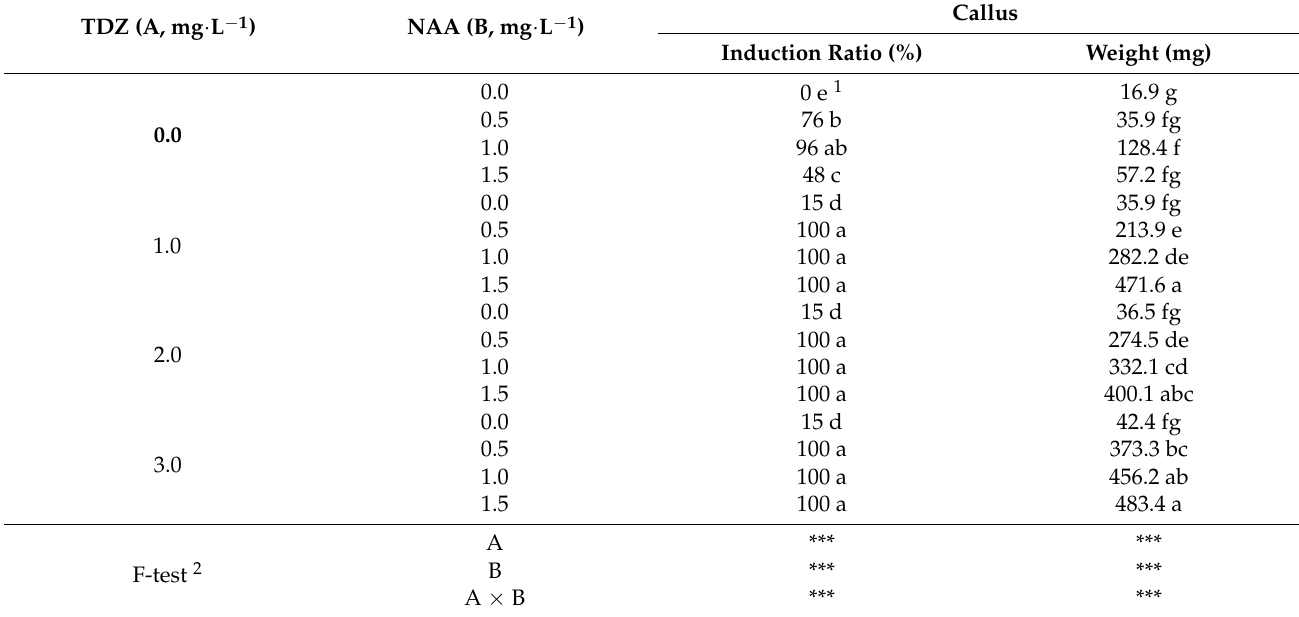
Table 1. Callus induction from the young leaf explants of Cotoneaster wilsonii